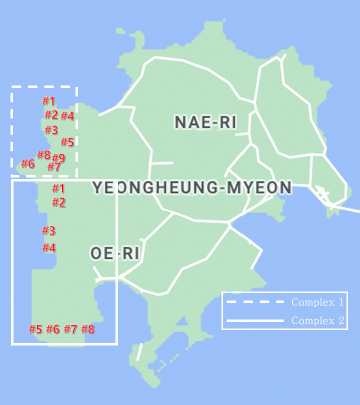
Figure 2. Map on Yeongheung wind power complex (# indicates each wind power